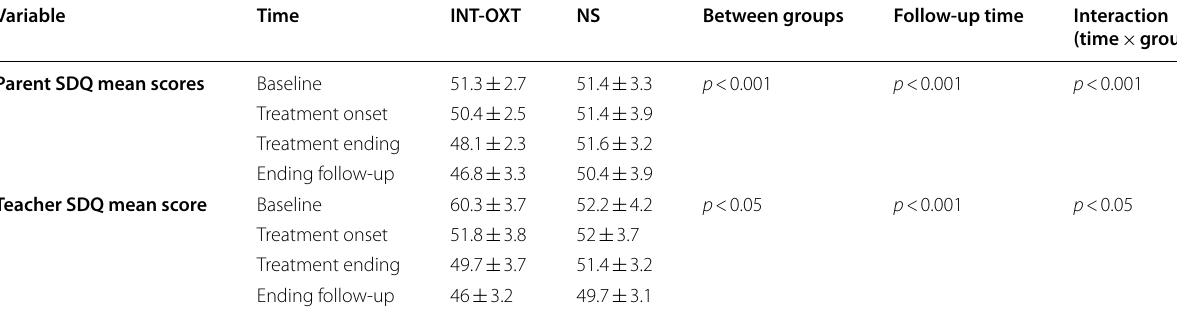
Table 3 Strengths and difficulties questionnaire (SDQ) mean scores